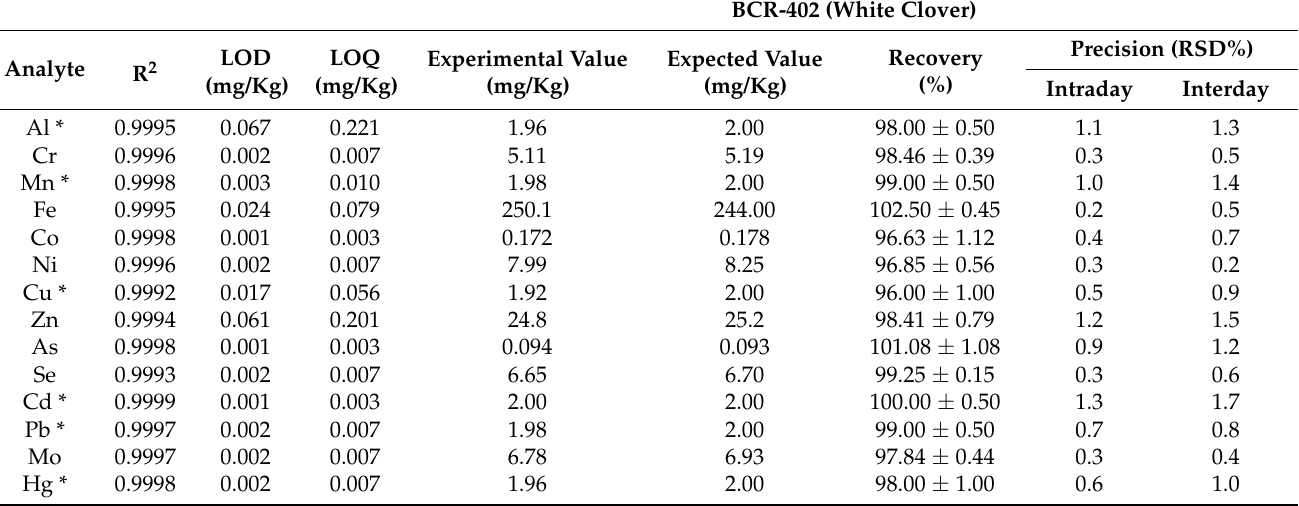
Table 2. Analytical validation of ICP-MS and TDA-AAS methods of analysis performed in terms of linearity, limit of detection (LOD), limit of quantification (LOQ), accuracy ( n = 6) and precision ( n =